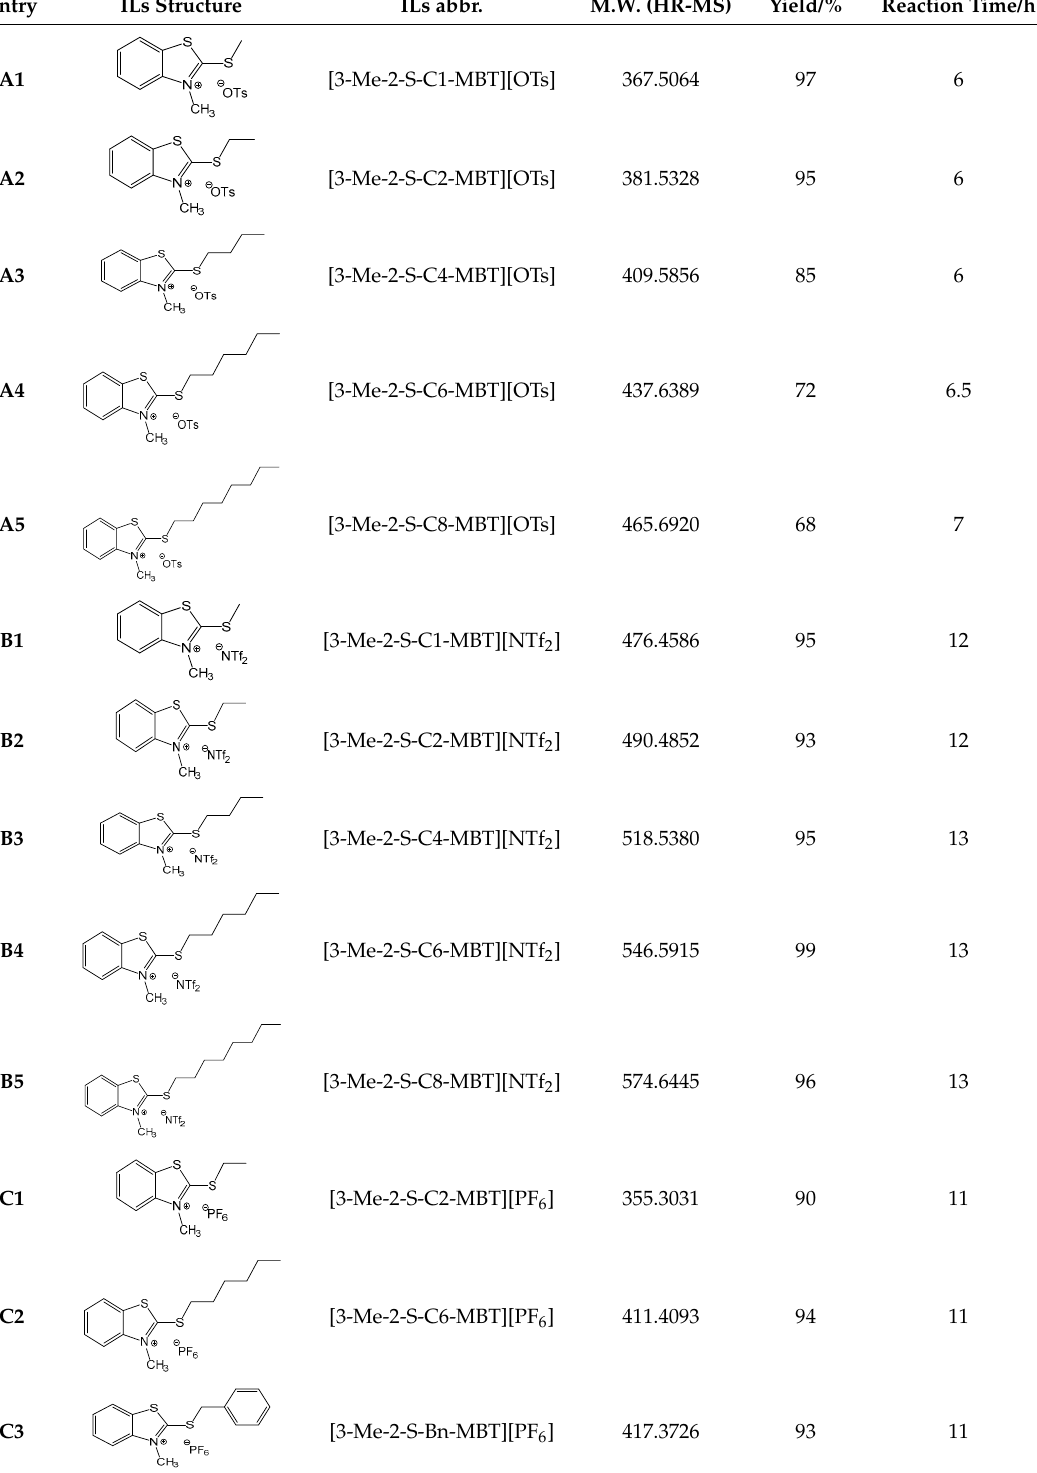
Table 1. The structures, yields, and other information of the prepared ILs.